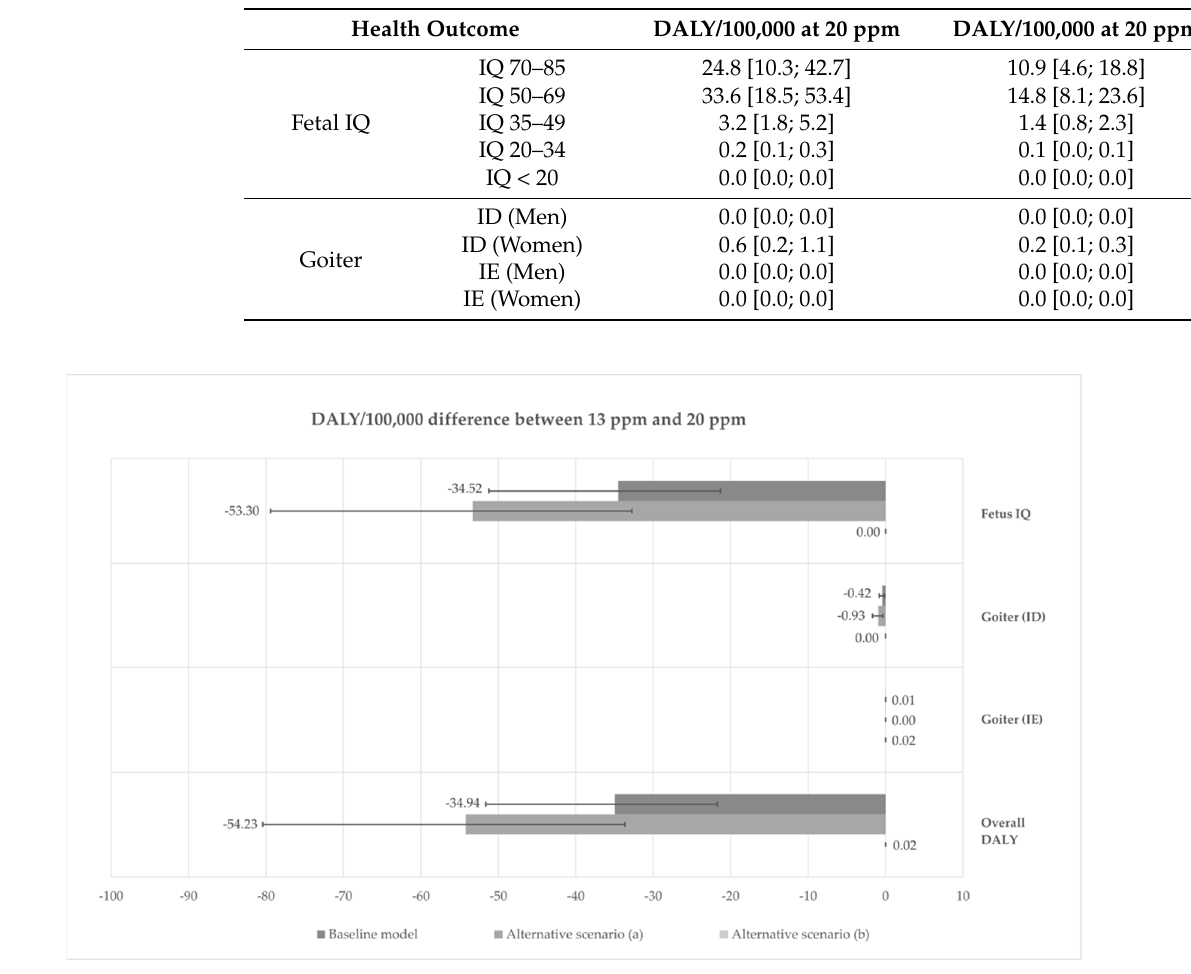
Figure 2. Annual DALY difference per 100,000 per health effect and summed over health effects between fortification levels 13 and 20 ppm for the baseline scenario and the two alternative scenar- ios.